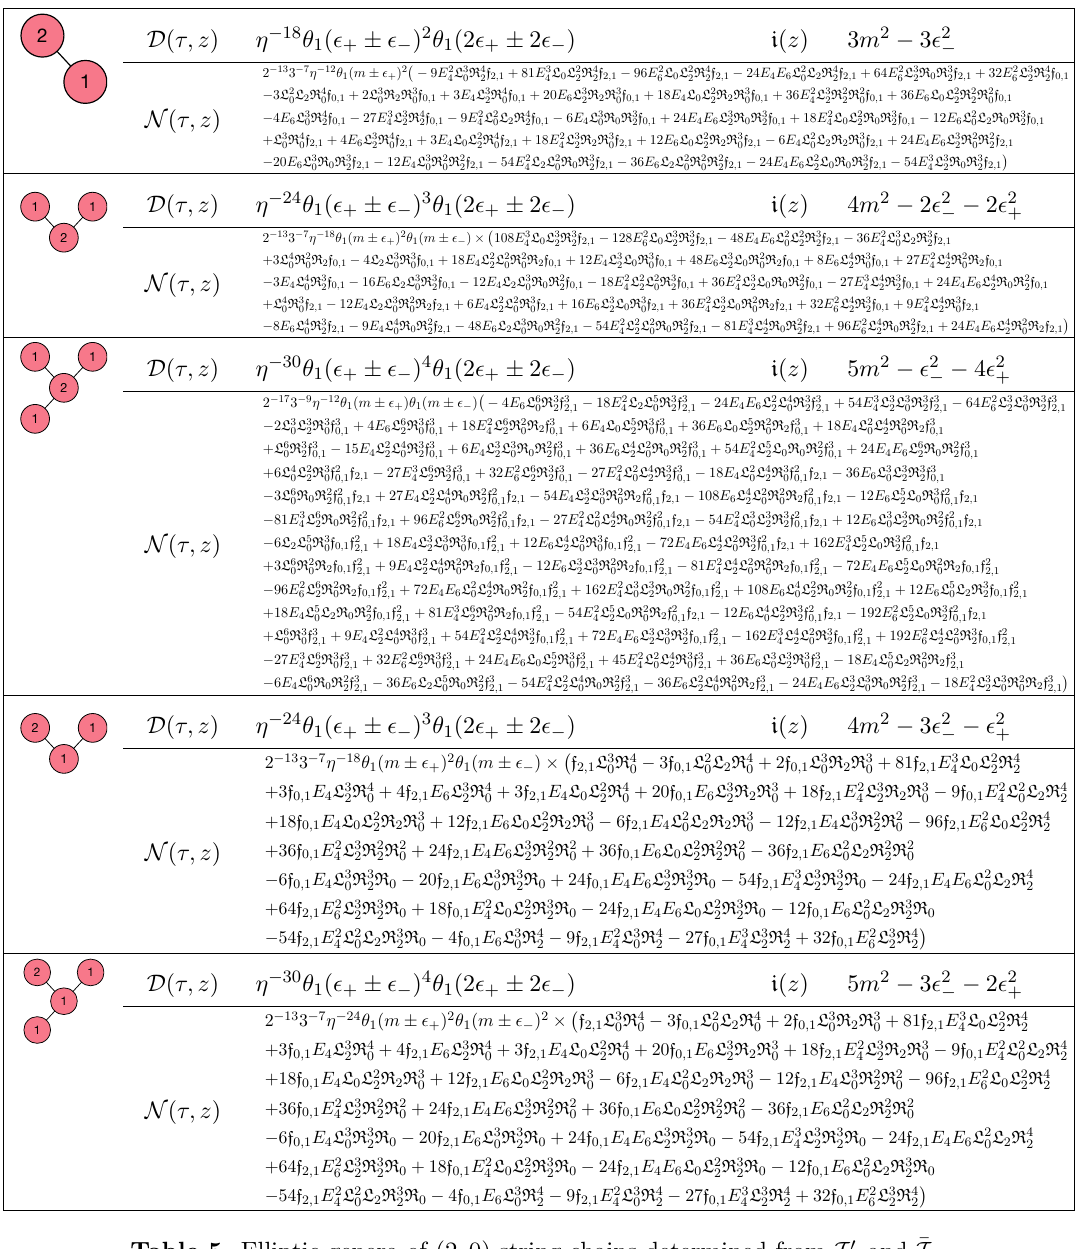
Table 5 . Elliptic genera of (2 ; 0) string chains determined from I 0